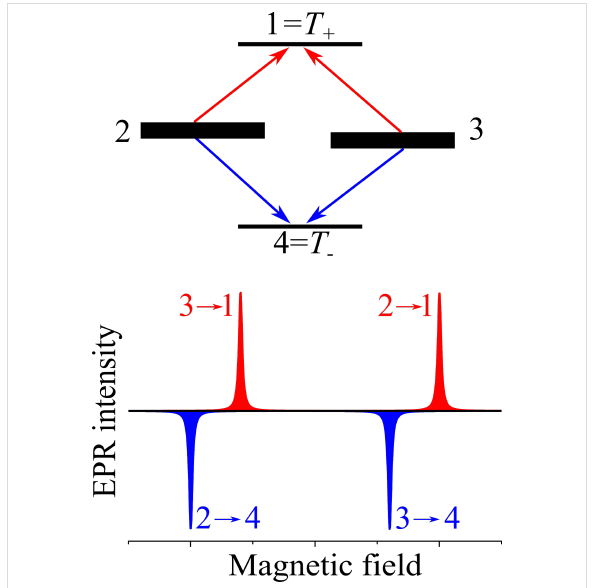
Figure 10: Top: Populations of the electronic spin state of an SCRP – when the radical pair is singlet-born initially, only the two central states, |2 and |3 have “singlet character” (each of them is a superposition of | S and | T 0 ) and are populated, resulting in two EPR transitions in absorption and two in emission. Positions of the energy levels are not to scale. Bottom: Schematic representation of the corresponding CIDEP spectrum, consisting of two anti-phase